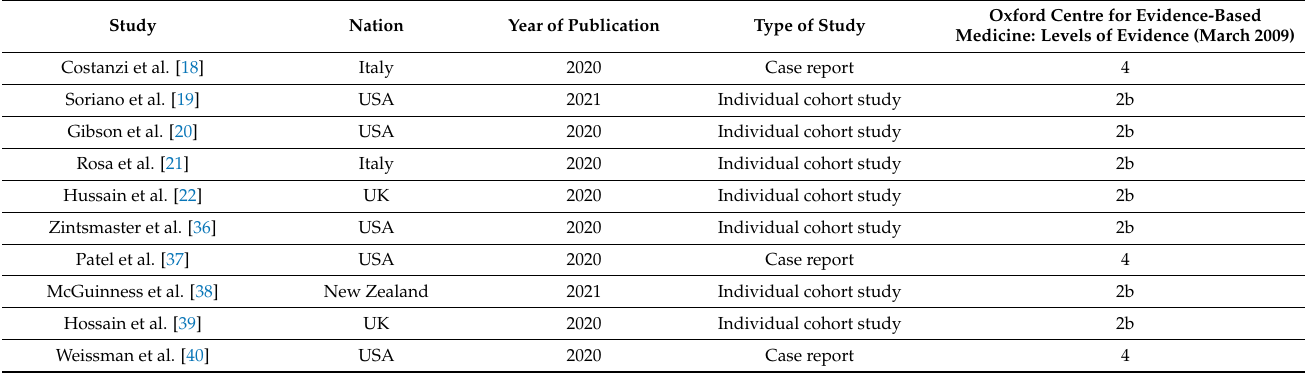
Figure 1. PRISMA flow diagram of study research. Table 2. Included studies—Individual cohort study and case report.